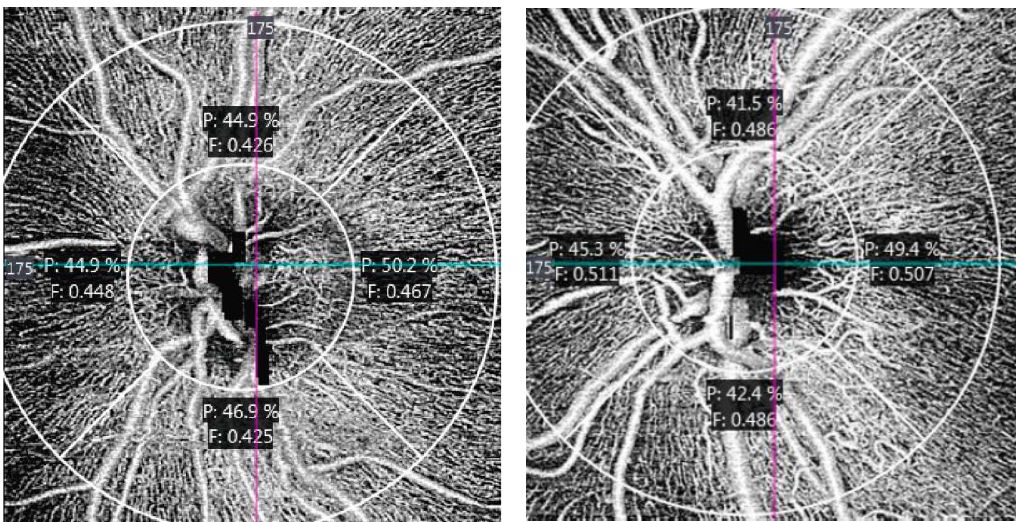
Figure 13. ASD ( left ) and NT ( right ) optic nerve head OCTA of two age and sex-matched participants in this study. Note that perfusion (P) is higher and flux index (F) is lower at the inferior quadrant in ASD participant.